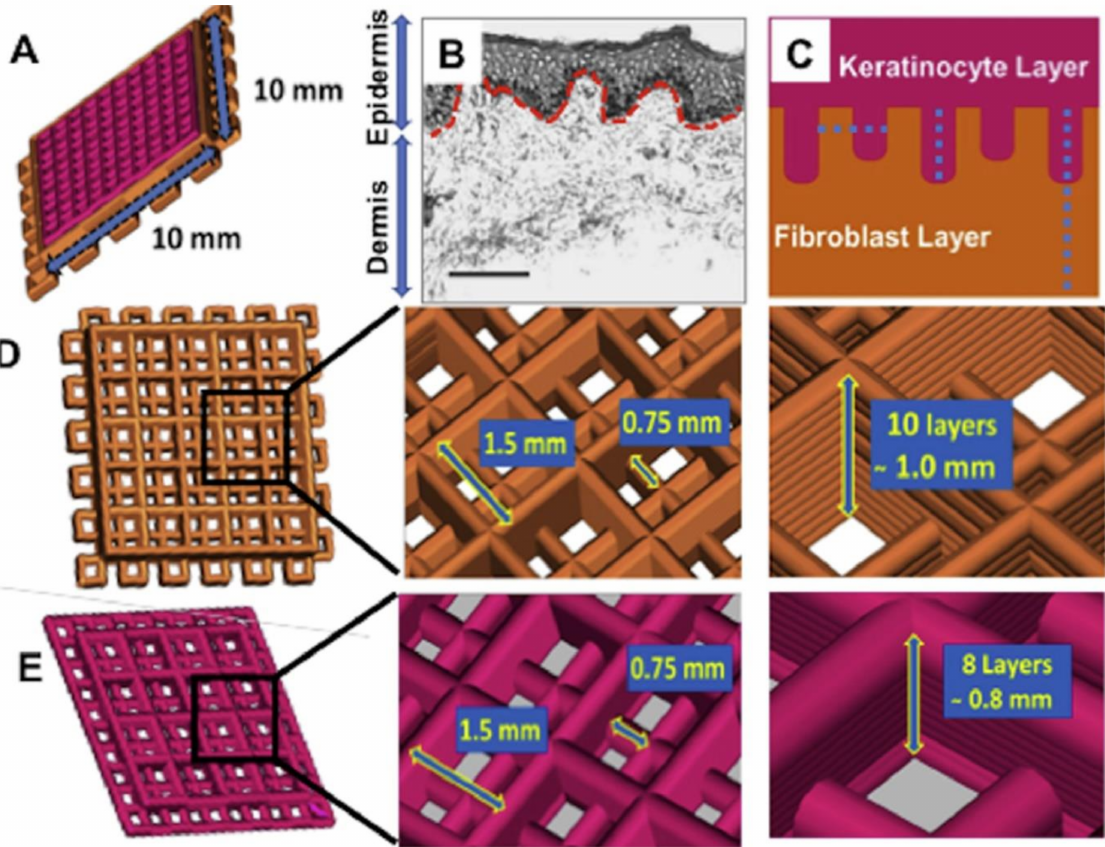
Figure 7. Schematic representation of the design of 3D Bioprinted construct. ( A ) Graphical representation of the Computer- Aided Design of the dual-layered skin model. The epidermis has been designed to create the dermis at regular intervals to form rete ridges. ( B ) Human skin representation, showing the dermis DEJ. ( C ) The structure design strategy for the 10 mm × 10 mm. ( D , E ) Detailed layer design dimensions of the dermal and epidermal layers. Design dimensions of the dermal layer (10 layers) and epidermal (8 layered filaments, arranged perpendicular to each other (in X and Y axes) with an interfilament spacing of 0.75 mm and Z-axis increment of 0.08 mm between each layer). Photo used with permission [116]